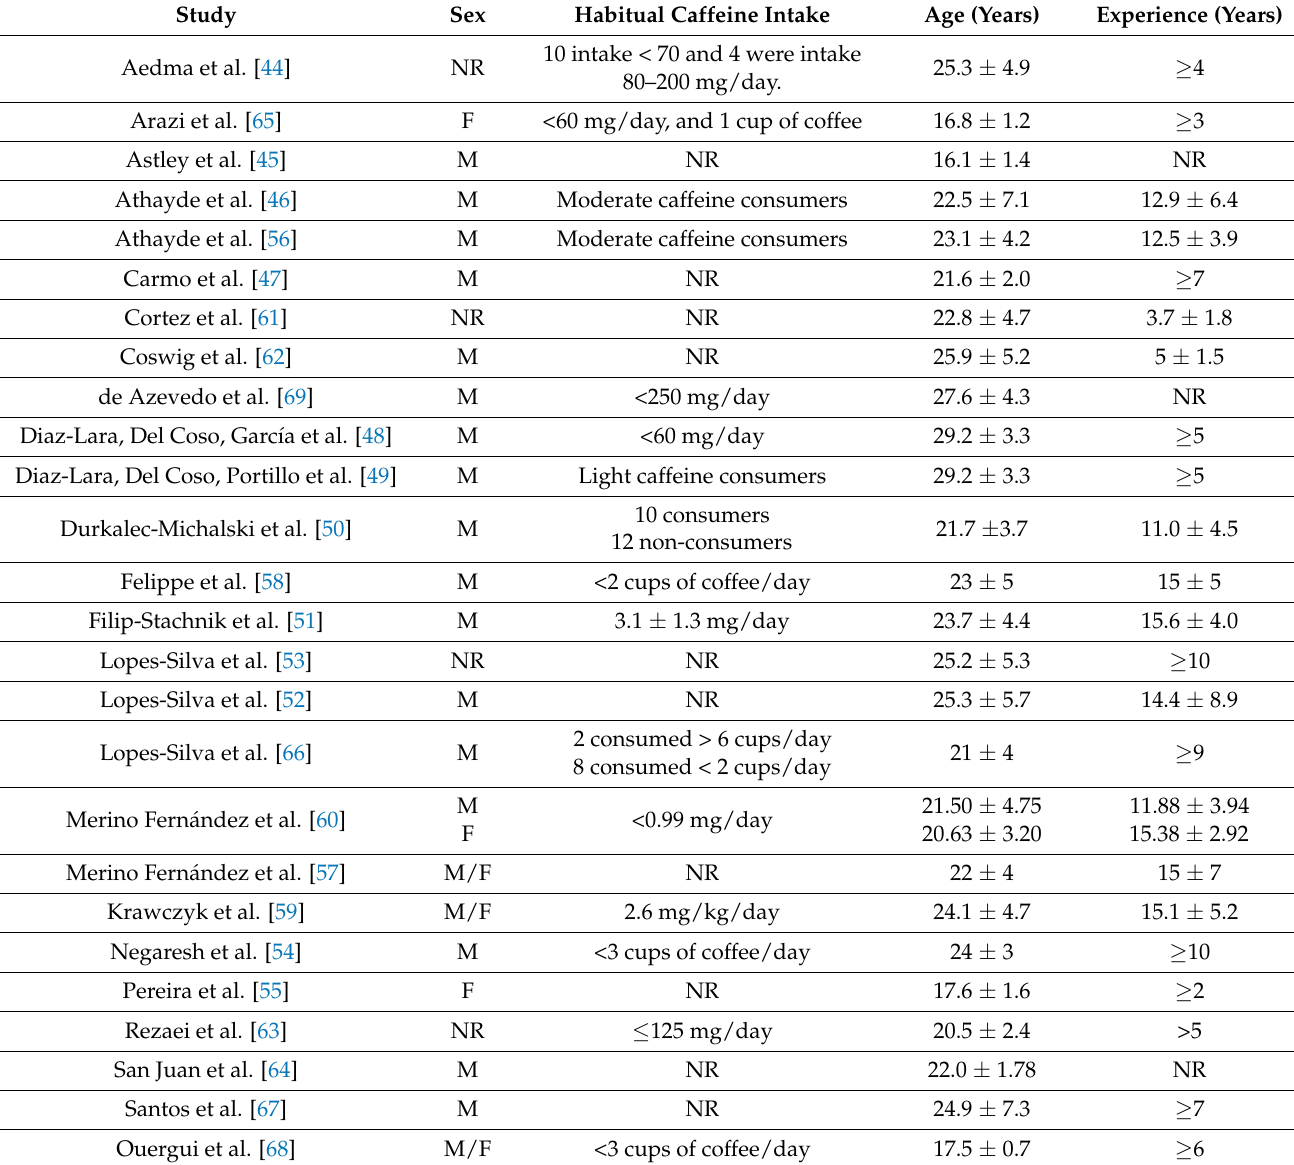
Table 3. Characteristics of the population investigated in different studies